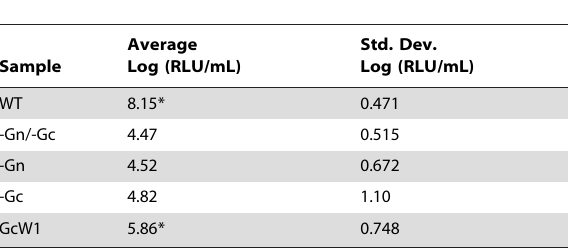
Table 3. Encapsidated genome required for efficient cellular